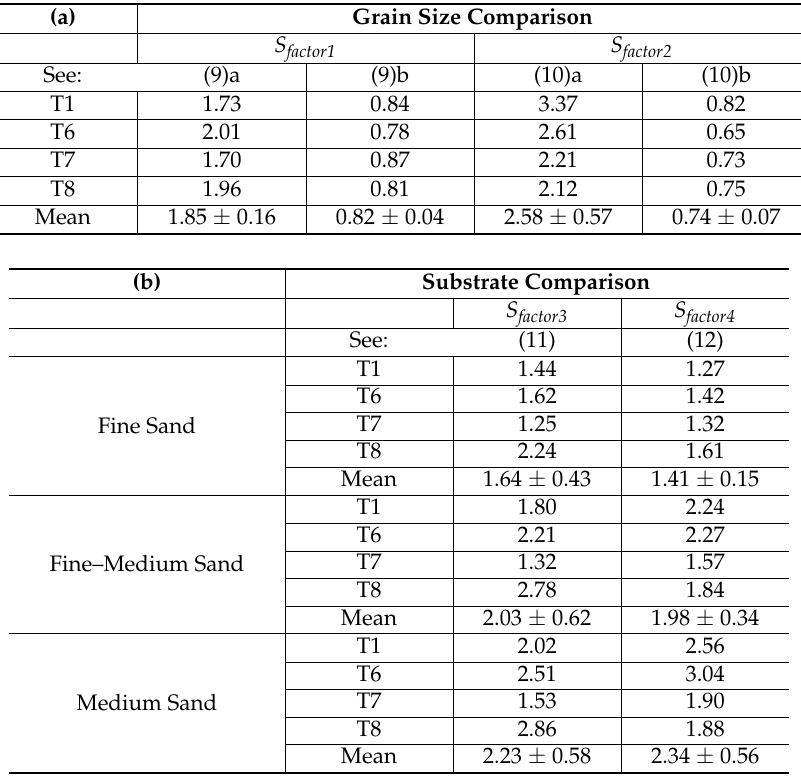
Table 9. Ratios for ( a ) S factor1 and S factor2 and ( b ) S factor3 and S factor4